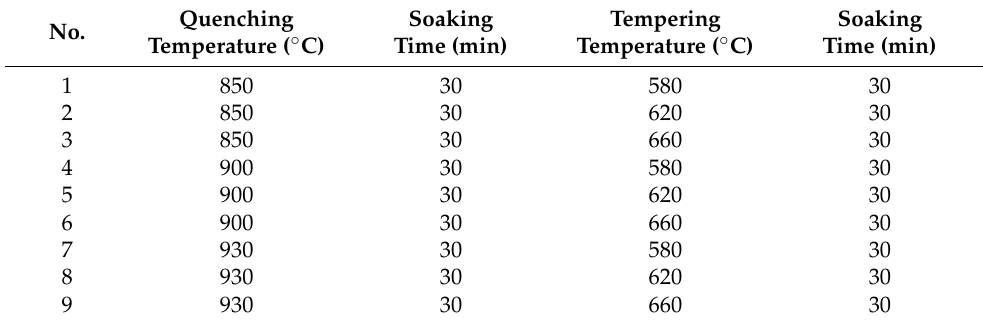
Table 2. Detailed parameters for various heat treatment processes.